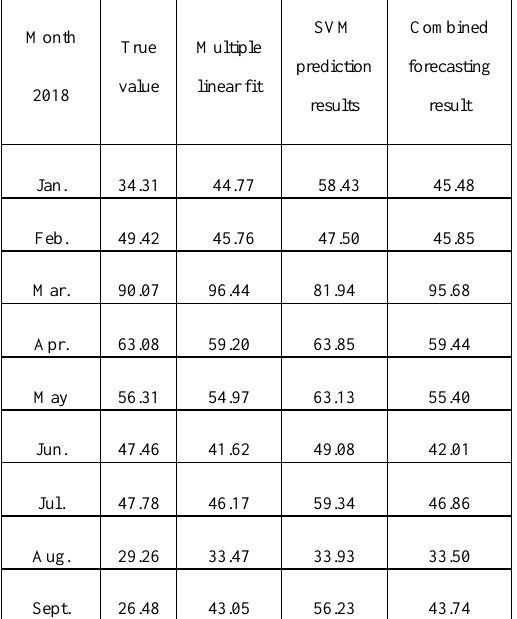
Table 6.Combined prediction results (PM2.5 concentration (ug/m 3